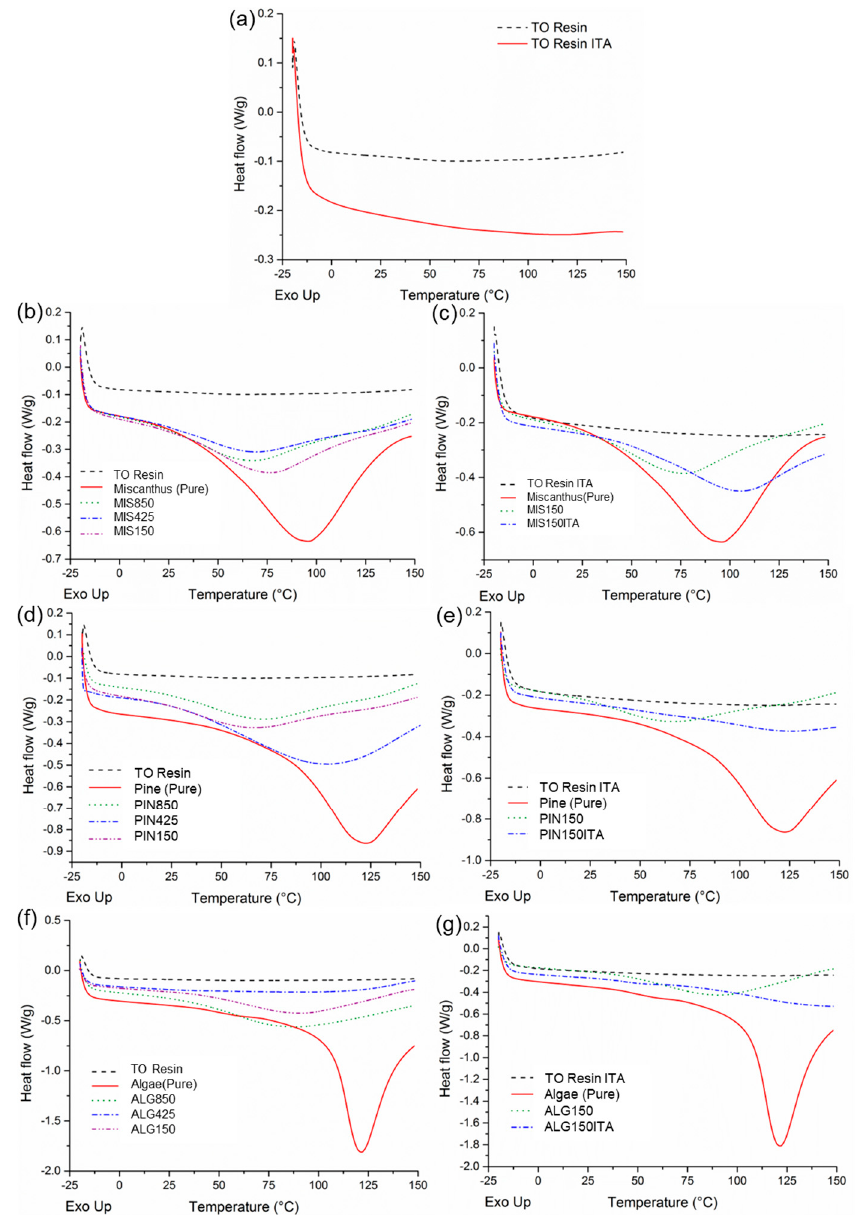
Figure 3. DSC curves of resins without reinforcement ( a ), silvergrass composites with different particle sizes ( b ), silvergrass composites with and without ITA ( c ), southern pine composites with different particle sizes ( d ), southern pine composites with and without ITA ( e ), algae composites with different particle sizes ( f ), and algae composites with and without ITA ( g ).